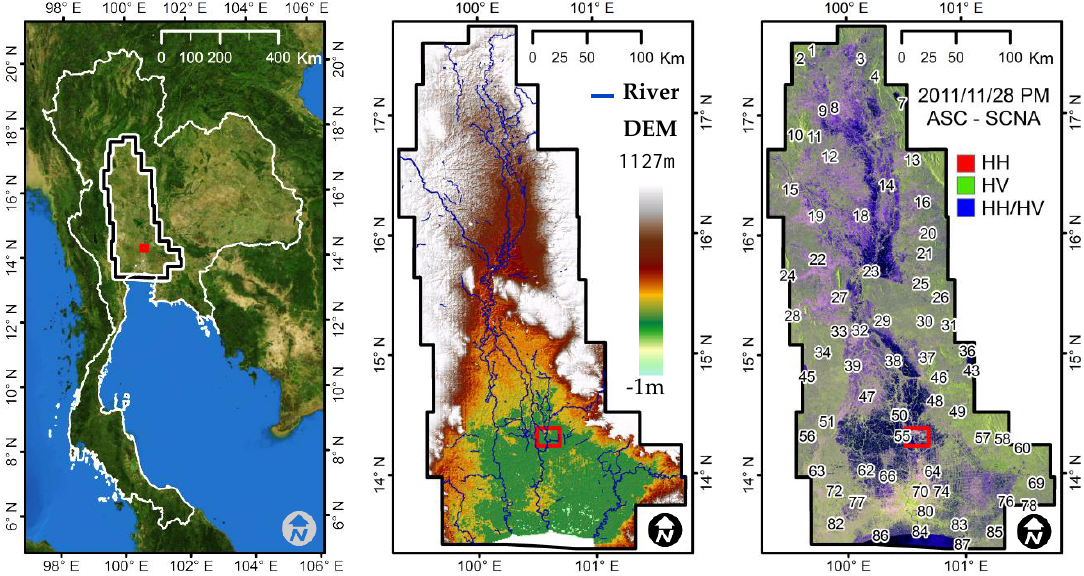
Figure 1. Map showing the study area ( left ), where the black border delimits the Chao Phraya river basin in central Thailand, and the red square delimits Ayutthaya City. Topographic map ( middle ), with main streams on the DEM. Water reference map showing 87 water references throughout the study area on a RADARSAT-2 image ( right ). Table 1. Summary of the RADARSAT-2 image data properties used in this study.